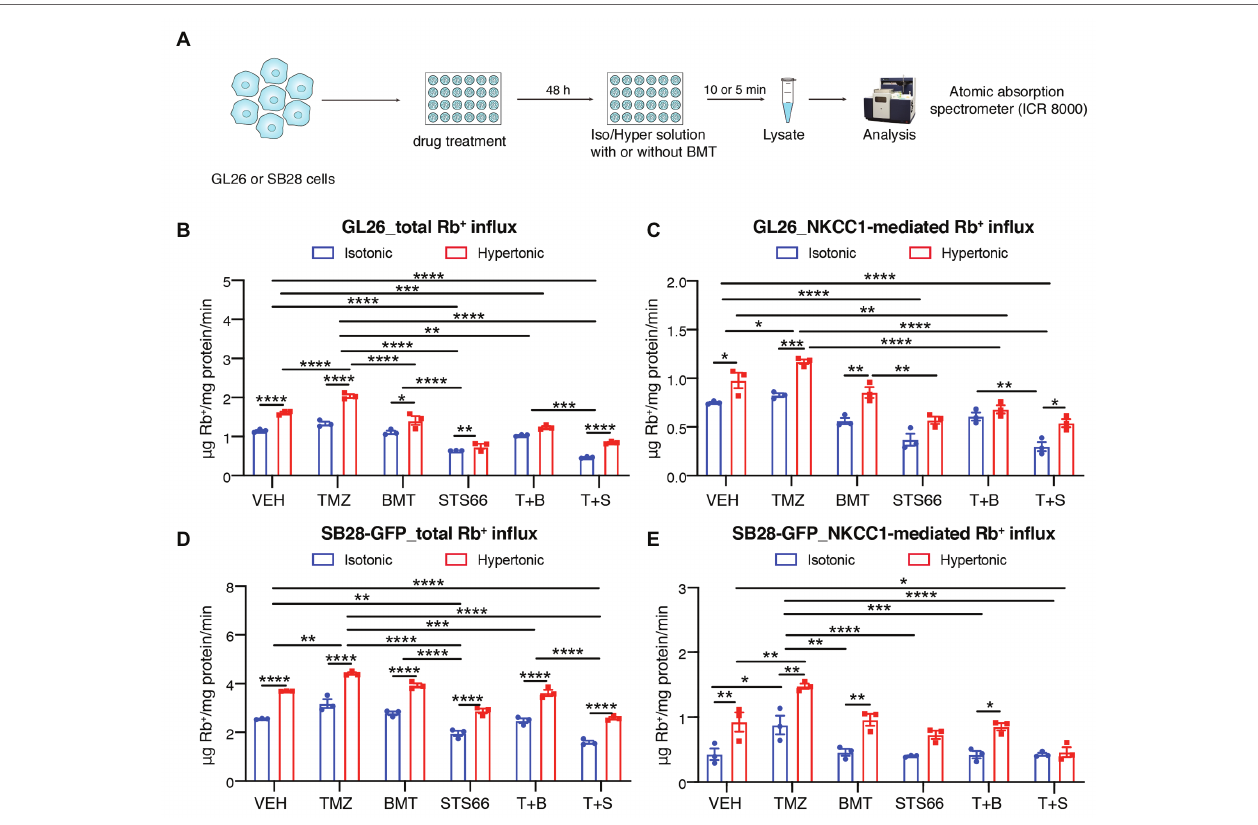
FIGURE 2 | STS66 reduces glioma K + (Rb + ) influx in combination of chemoreagent temozolomide. (A) Experimental protocol. (B–E) Total Rb + influx (B,D) and NKCC1-mediated Rb + influx (C,E) . GL26 cells were exposed to DMSO (Veh), temozolomide (TMZ, 100 μ M), BMT (10 μ M), STS66 (60 μ M), T + B, or T + S combined for 48 h. Rb + influx into cells under either isotonic (310 mOsm) or hypertonic (400 mOsm) solutions was assayed for 5–10 min and determined using ICR 8000. Data are means ± SEM ( n = 3), * p < 0.05, ** p < 0.01, *** p < 0.001, **** p <